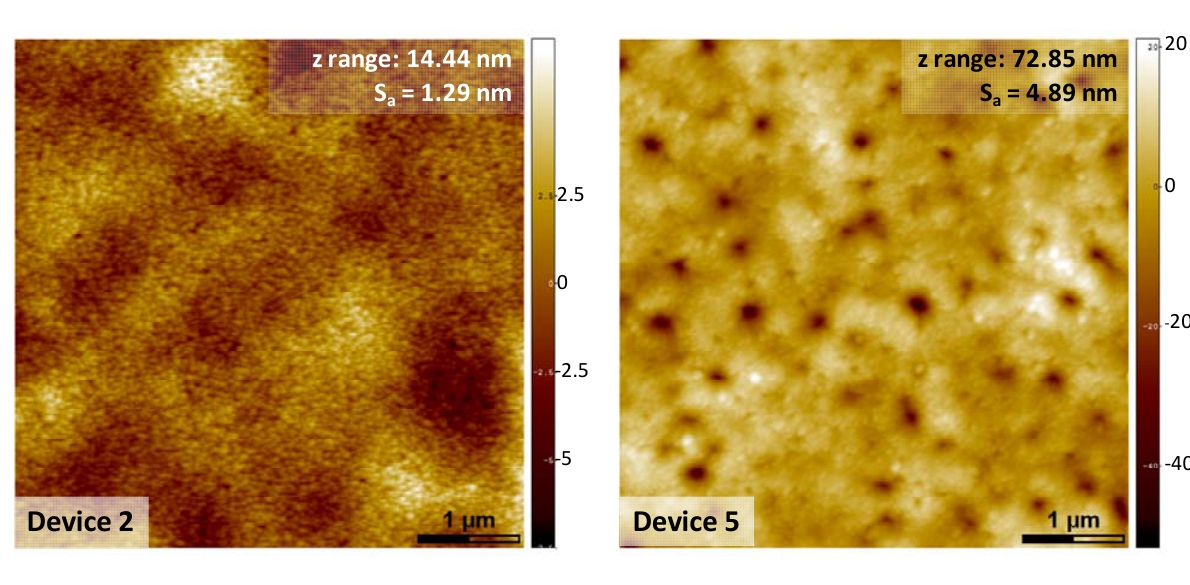
Figure 10. AFM topography images of the active layers of Device 2 and Device 5 with their respective height difference ( z range) and the calculated surface roughness (S imaging was conducted on the active layer of the fully assembled